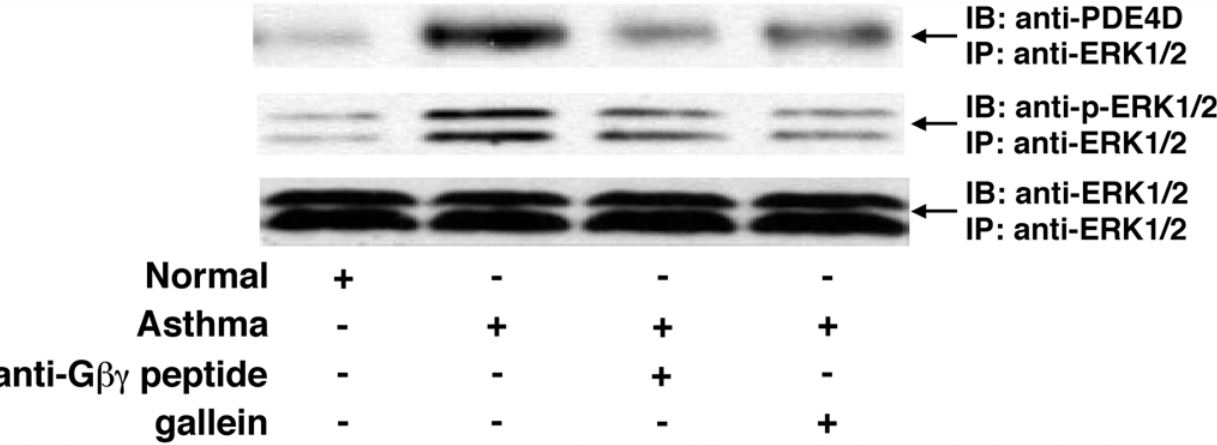
Fig 5. Inhibition of G βγ signaling suppresses intrinsically increased direct coupling of p-ERK1/2 and PDE4D proteins in asthmatic HASM cells. Western blotting in Co-IP analysis demonstrating that, under the same protein loading conditions yielding similar β -actin levels, relative to normal cells, asthmatic HASM cells exhibit distinctly increased direct co-localization of immunoblotted (IB) PDE4D protein (apparent mol. wt. 100 kDa) with immunoprecipitated (IP) ERK1/2, the latter associated with heightened IB-detected p-ERK1/2. This heightened protein complex formation is acutely reversed (within 30 min) in asthmatic HASM cells treated with either anti-G βγ blocking peptide or gallein. The immunoblots shown are representative of 3